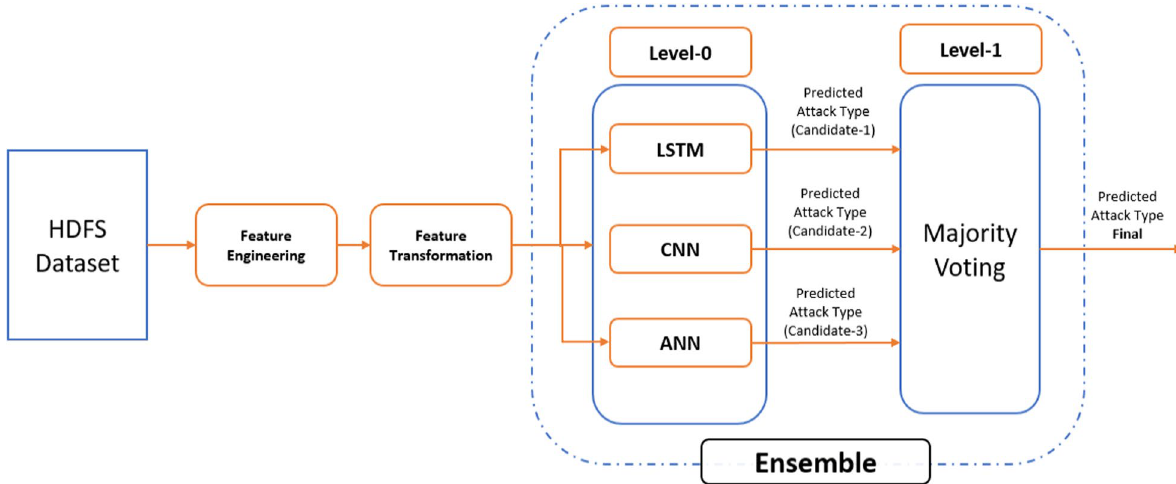
Fig. 4 Deep ensemble configuration for multi-class prediction